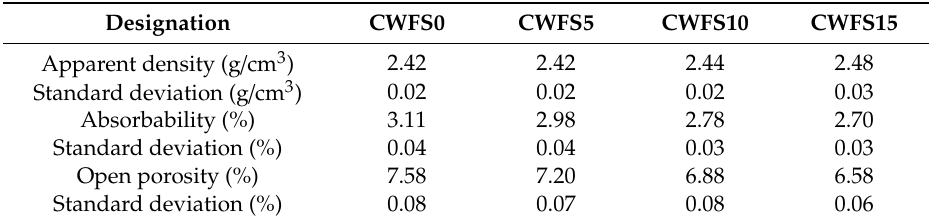
Table 8. Physical properties.